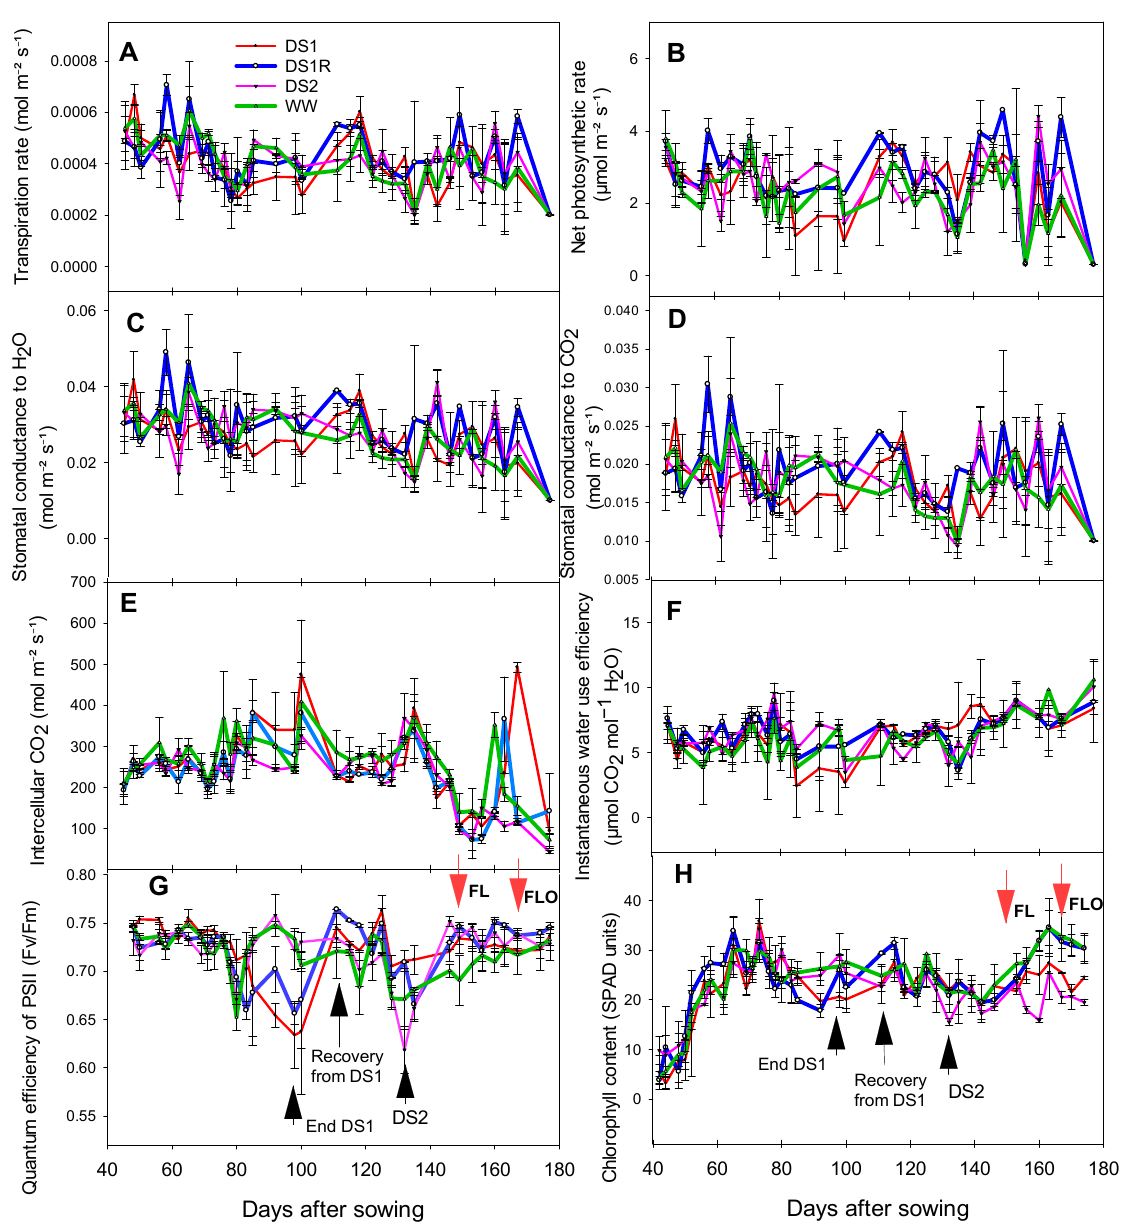
Figure 6. Transpiration rate ( A ), net photosynthetic rate ( B ), stomatal conductance to water ( C ), stomatal conductance to CO 2 ( D ), intercellular CO 2 ( E ), instantaneous water use efficiency ( F ), maximum yield of PSII ( G ), and chlorophyll content ( H ) recorded during the experiment, compared among different water treatments. Presented data are average value with standard error. FL: flag leaf stage, FLO: flowering.